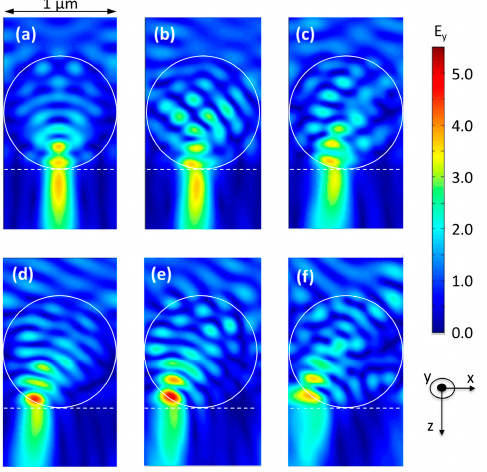
Figure 1. Mapping of the E y component of the electric field for λ = 365 nm at different incidence angles: ( a ) 0°; ( b ) 5°; ( c ) 12°; ( d ) 20°; ( e ) 25° and ( f ) 30°.